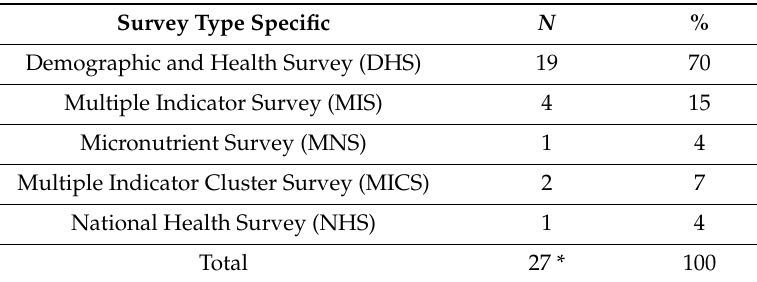
Table 3. Description of the survey types in this anaemia review.